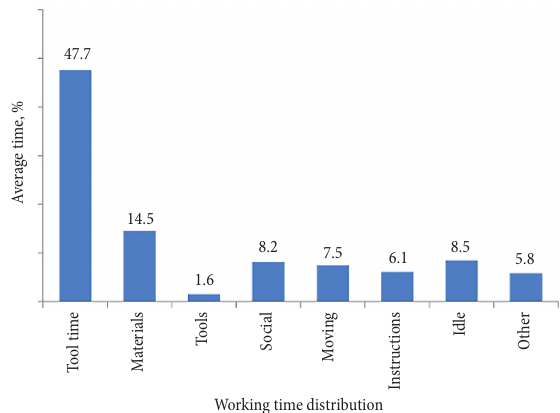
Working ime Fig. 1. Working time distribution of the 38 construction workers